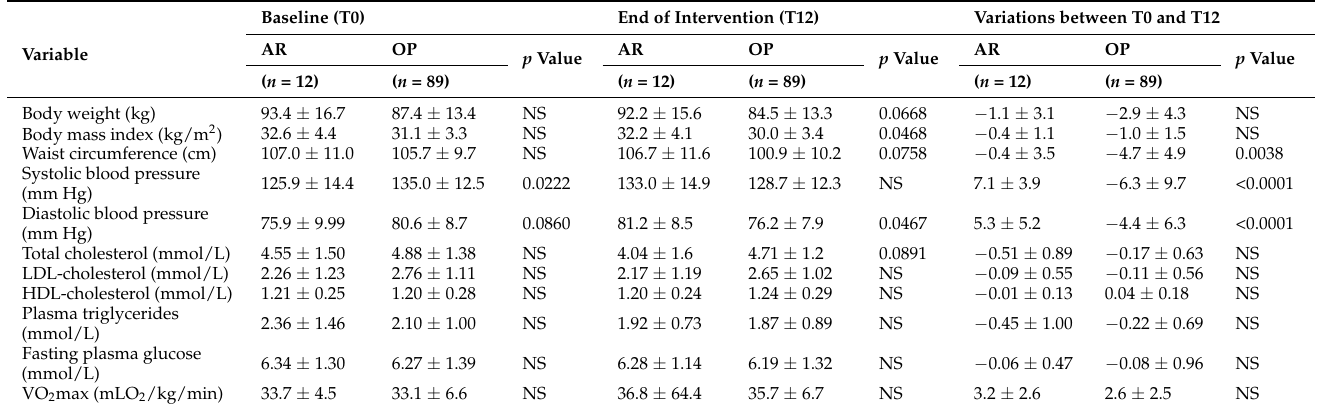
Values are mean ± SD. Abbreviations: AR, adverse responders; OP, other